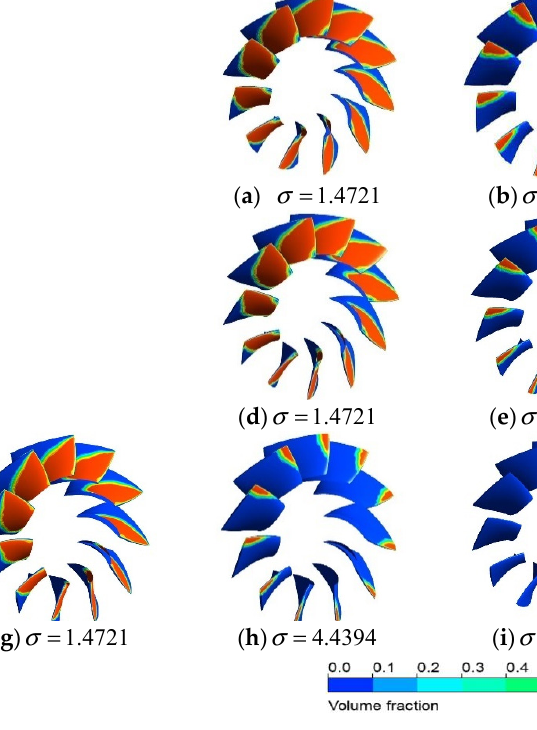
Figure 17. Water vapor phase volume fraction cloud under different oblique angles and cavitation